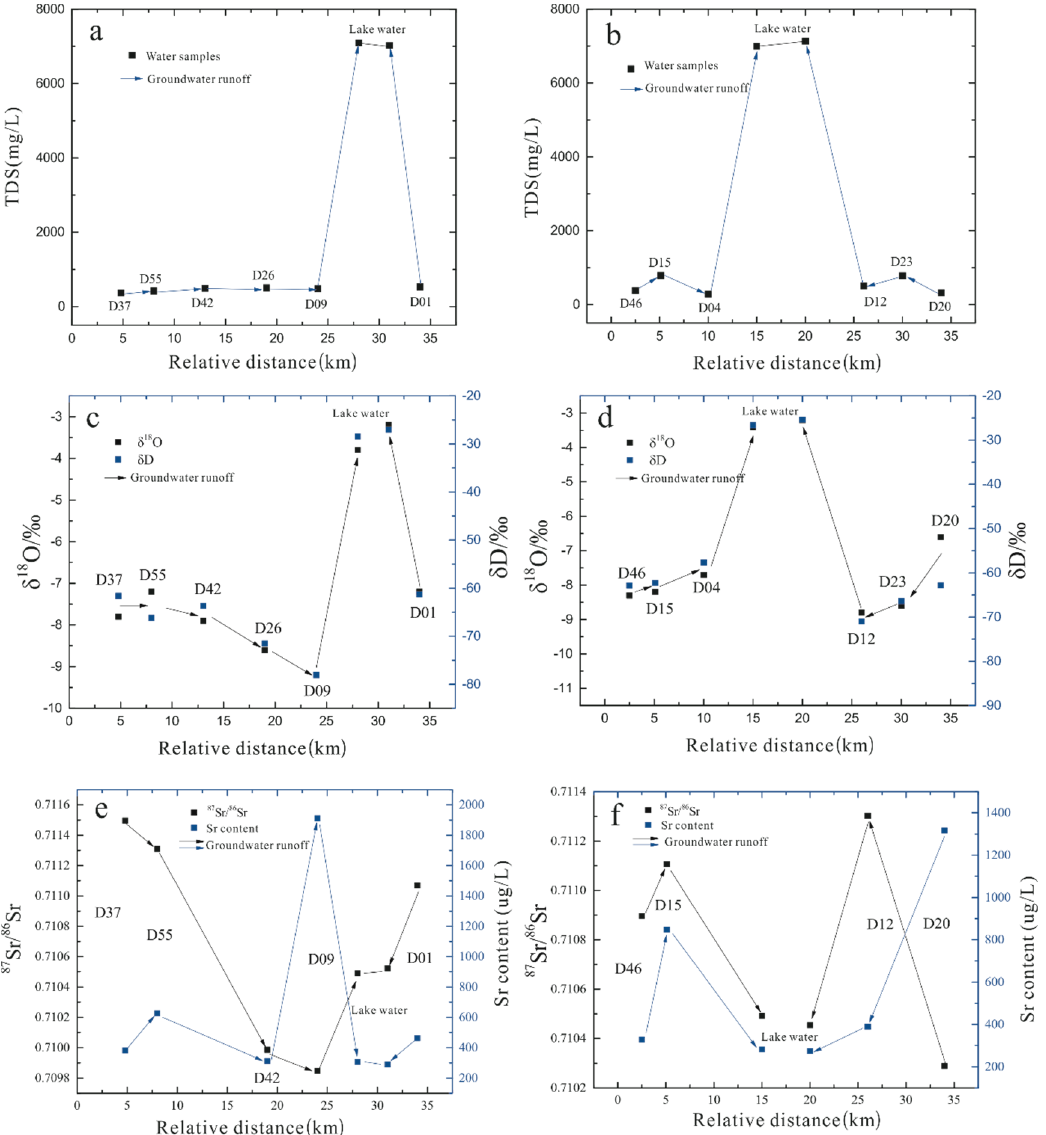
Figure 4. Change in TDS concentrations and isotopes (H, O, and Sr) along the groundwater flow